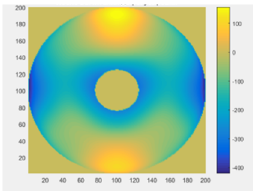
Fig. 2. Wavefront form in case of mirror support on manufacturing support cell.